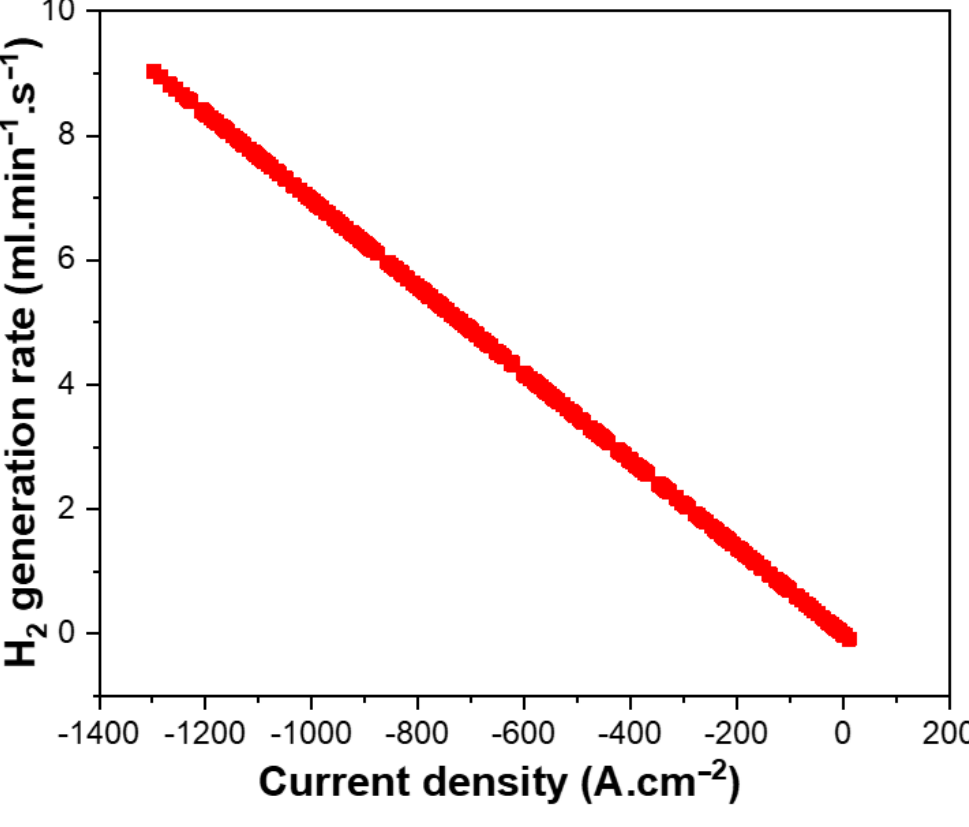
Figure 7. Hydrogen production rate based on cell current.